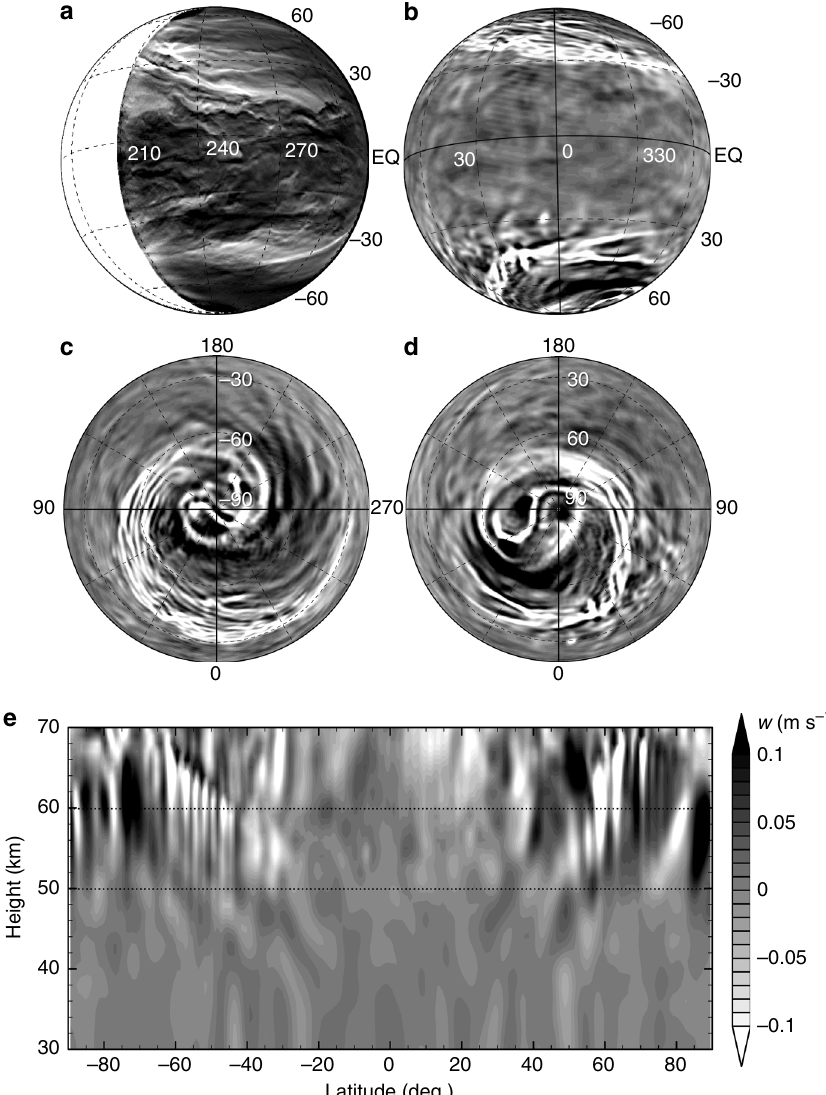
Fig. 2 Morphology of the observed and the simulated planetary-scale streak structures. a Edge-enhanced image of Venus ’ night-side obtained from the image in Fig. 1; see Methods for the edge-emphasis process. b Vertical velocity at an altitude of 60 km simulated in STD after 3 Earth years (about 9.38 Venusian solar days) of time-integration, shown as a satellite view mimicking the panel a . c , d Same as b but for orthographic views from the south pole and the north pole, respectively, at the same altitude. e Same as b but for meridional cross-section at lon = 60 deg.; horizontal dotted lines indicate 50 and 60 km heights, which are the approximate boundaries of the simulated low-stability layer. Note that the planetary-rotation direction in the simulation is opposite to that of Venus, but the panel b is displayed with a 180-deg. rotation to easily be compared with the Venus image shown in the panel a . The colour bar is common for the panels from b to